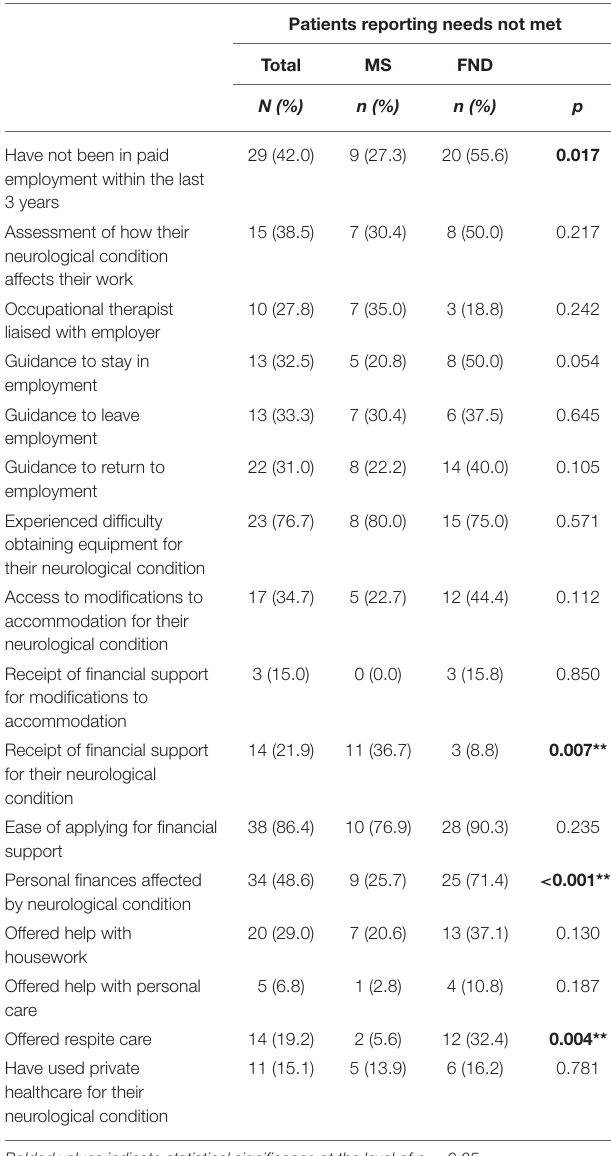
TABLE 4 | Patients reporting a problem regarding aspects of community care and